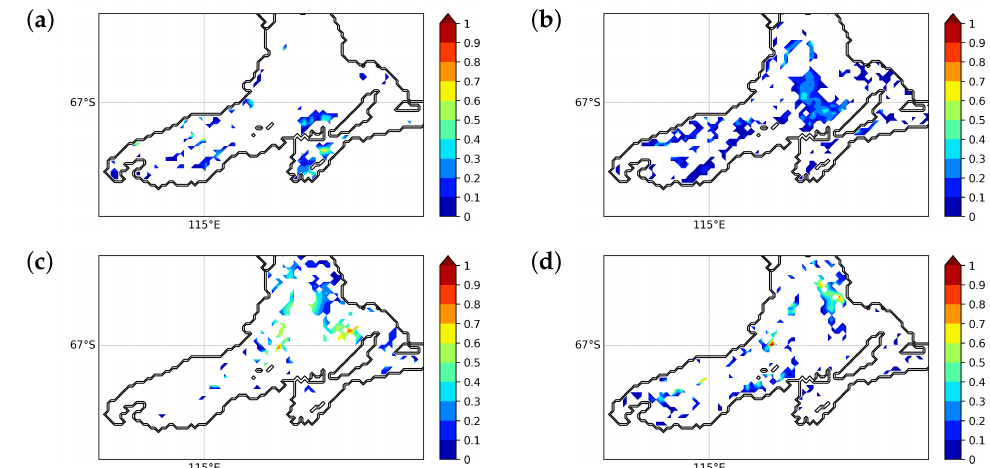
Figure 9. Locations in the TIS cavity where the mean basal melt rate increases in REF3mcpl compared to REF are related to an increased ocean temperature ( a ) or to an increased ocean current speed ( b ). Locations where the mean basal melt rate decreases in REF3mcpl compared to REF are related to a decreased ocean temperature ( c ) or to a decreased ocean current speed ( d ). The colour bar represents the normalised distance between each point and the regression line (value close to zero means a strong linear relationship).